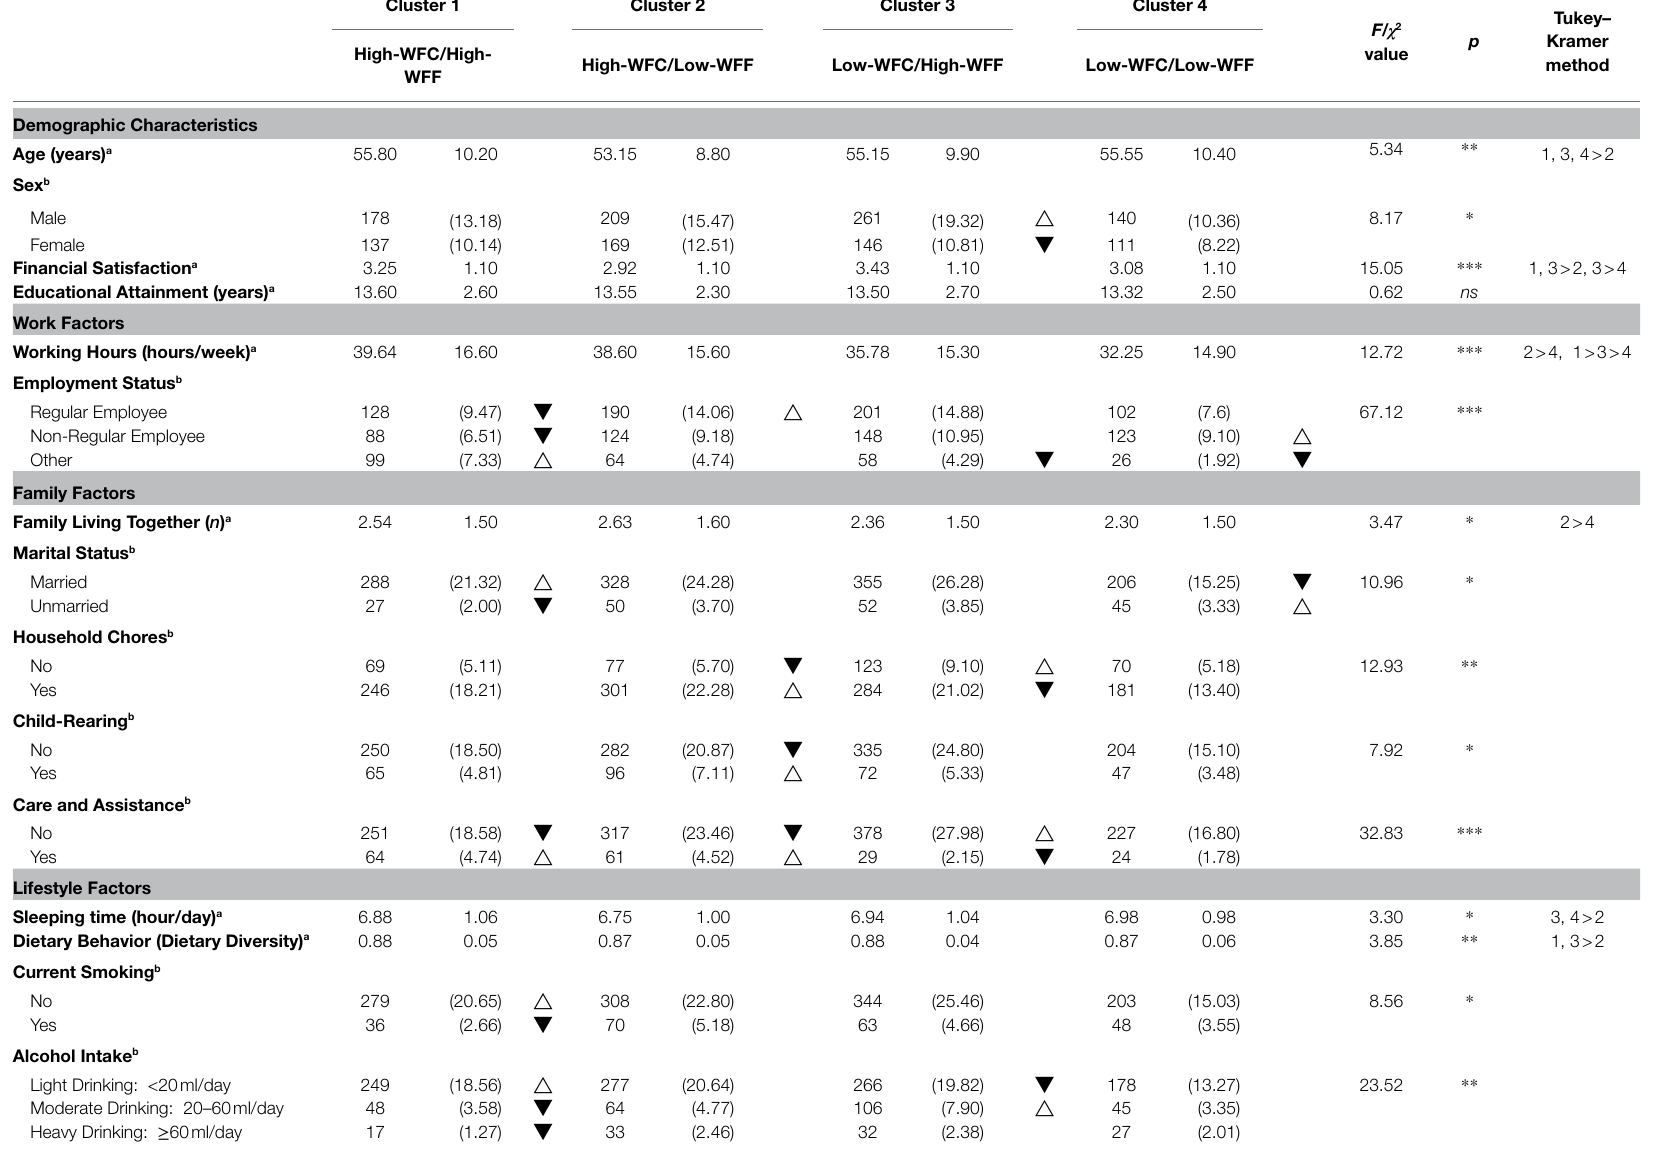
TABLE 2 | Demographic characteristics and work, family and lifestyle factors across work–family balance